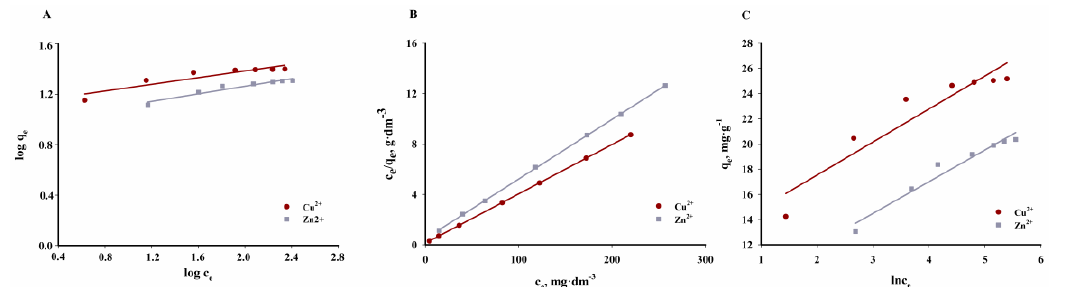
Figure 17. Freundlich ( A ), Langmuir ( B ), and Temkin ( C ) adsorption isotherms of Cu 2+ and Zn 2+ on SSB6 biochar ( T = 40 °C, t = 240 min, mass of adsorbent = 6.67 g·dm −3 , pH =